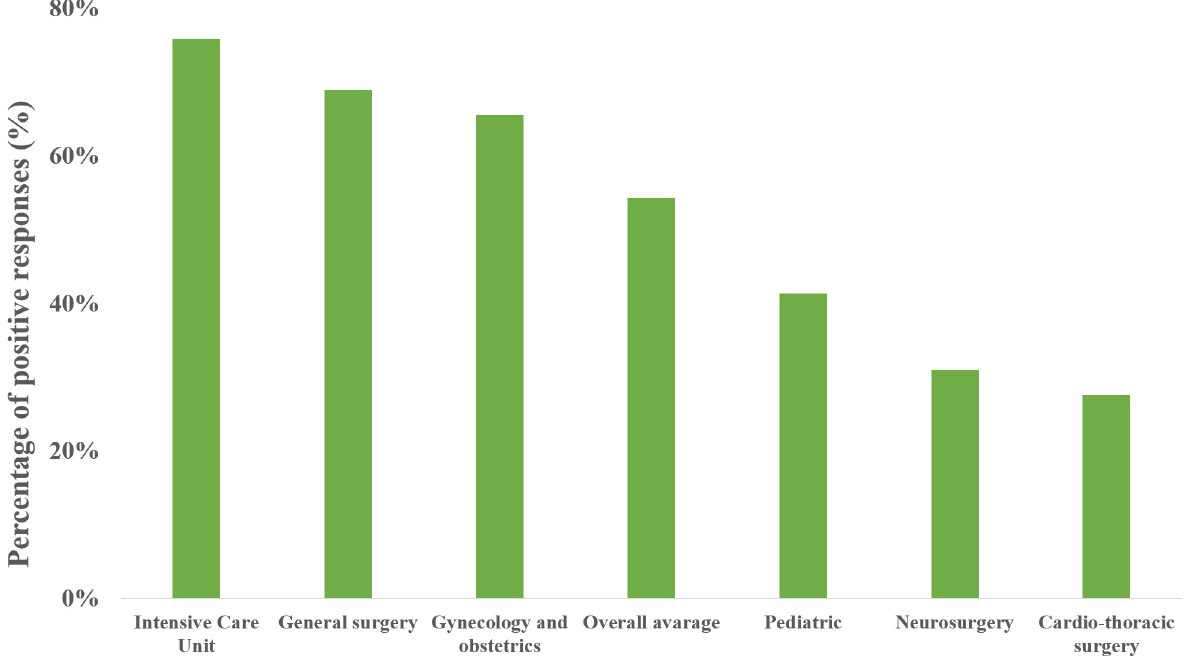
Fig 3. Increased time frame availability regarding clinical areas. The most and the least supplied clinical areas with availability of VL within 10 minutes in Croatia according to this survey (n = 29) and based on positive answers given to the following question: “At which workstation at your workplace do you have a VL available within 10 minutes? (Option for multiple answers!)”.